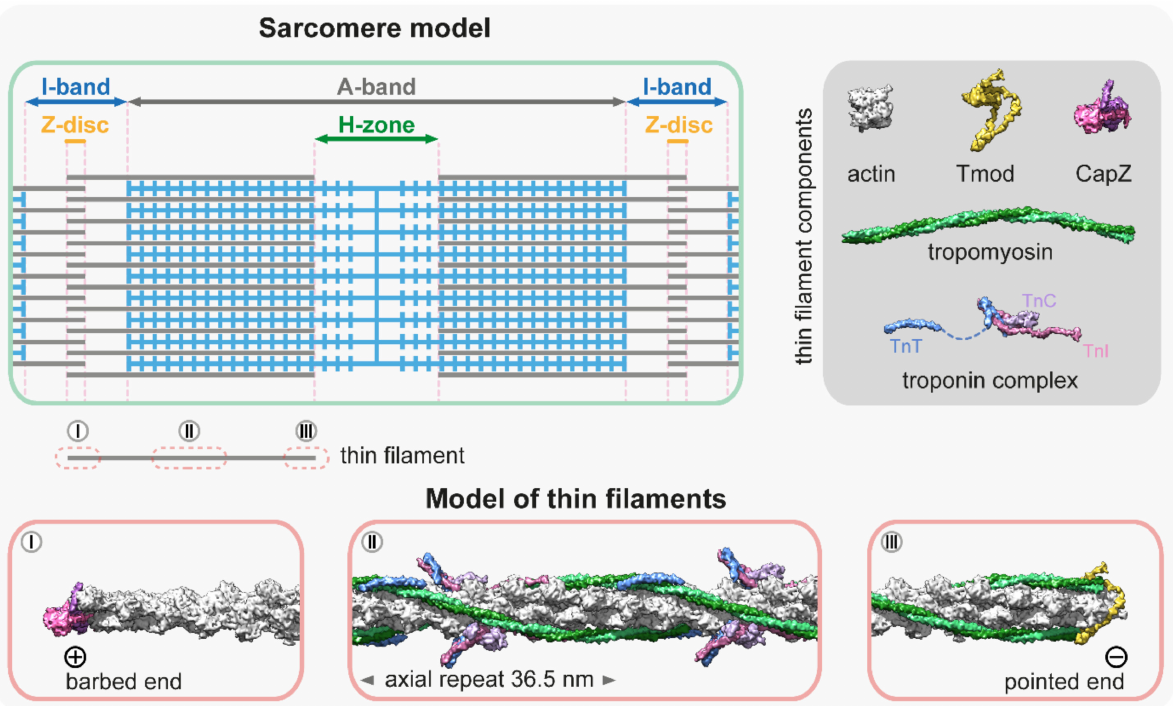
Figure 1. Molecular representation of the thin filaments. The schematic at the top left is a